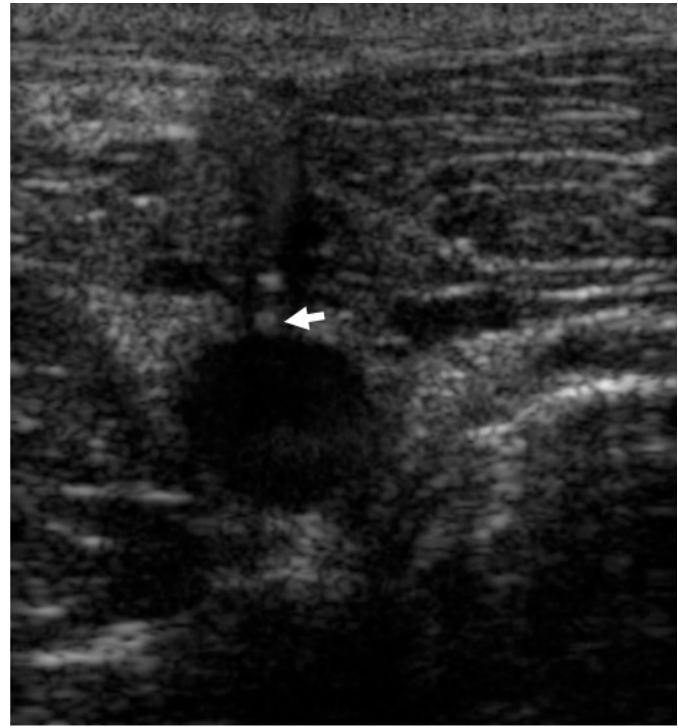
Figure 2. Transverse ultrasonography of the common carotid artery during percutaneous ultrasound-guided access. The tip of the needle is just above the artery (arrow).